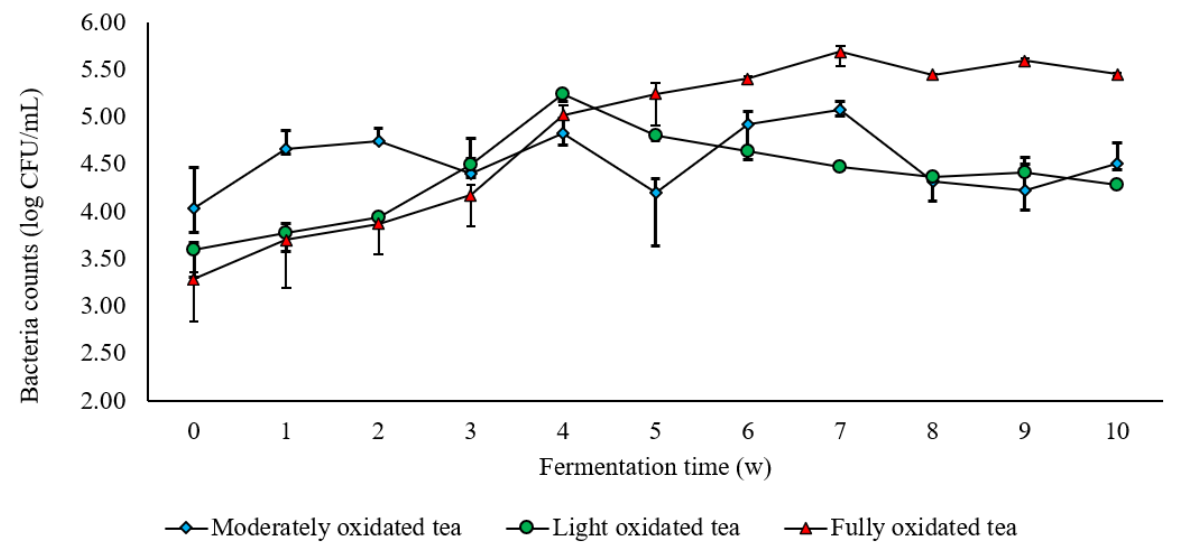
Figure 1. The variation in bacteria counts of Acetobacter pasteurianus during the fermentation of different oxidized teas. The mean values ± standard variation of three replications indicated a significant difference at p < 0.05.